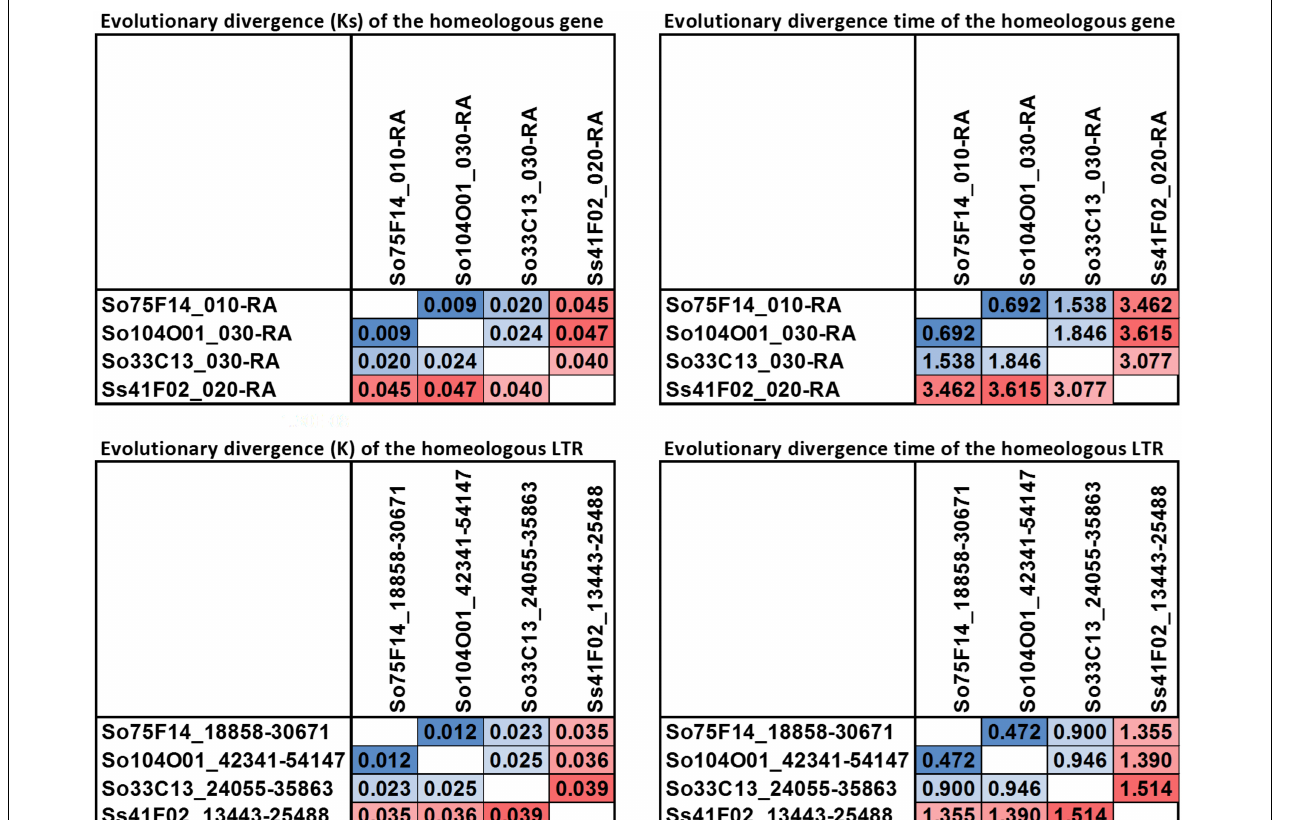
FIGURE 8 | Pairwise evolutionary distance for a homeologous gene and a LTR. The homeologous gene and LTR sequence share a higher similarity among the three So BACs than to the Ss BAC.